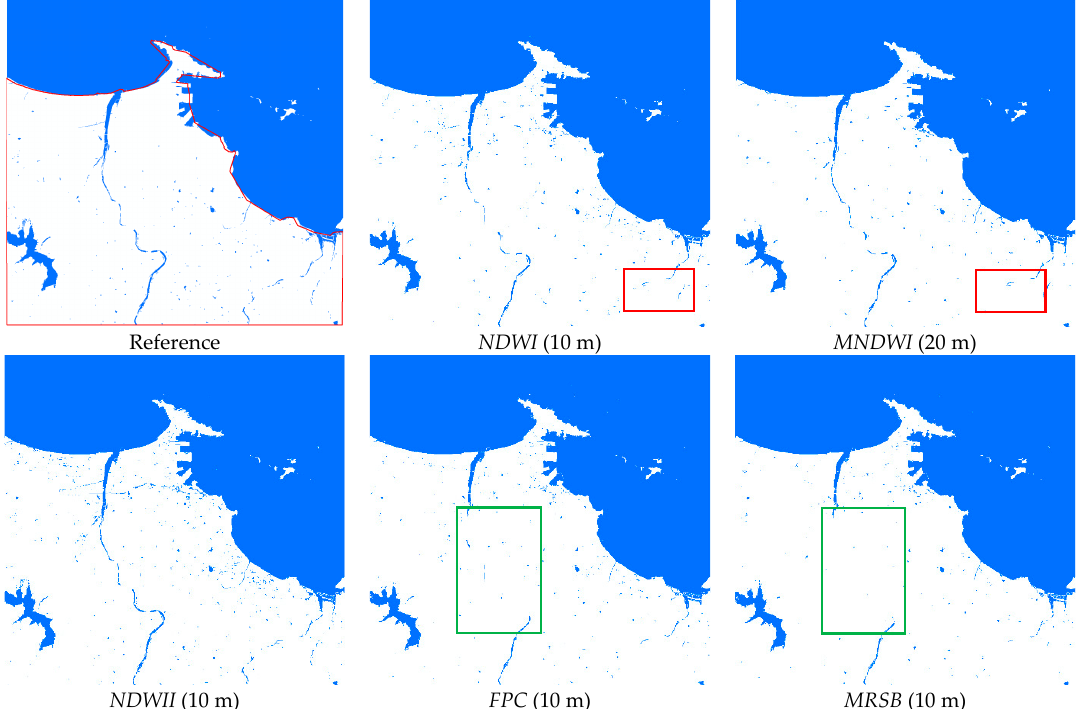
Figure 10. Final surface water maps (blue blocks) utilizing different approaches in Yantai. The reference image is the manual drawing by visual interpretation process. The red boundary in the reference excludes the ocean areas in the accuracy assessment, because such a large area of clear water pixels in ocean areas can always lead to a high extraction rate.